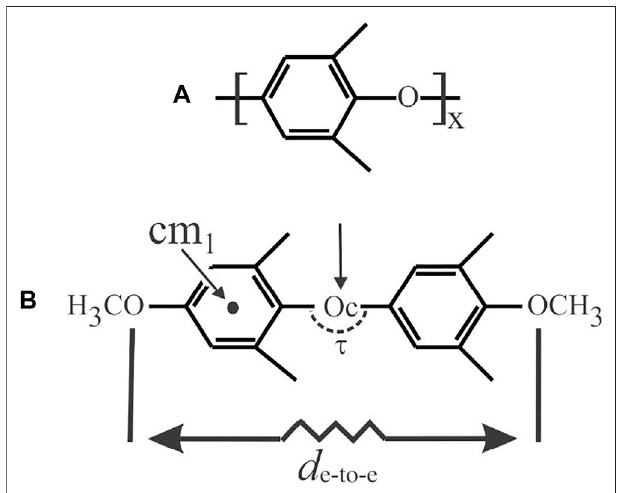
FIGURE 3 | PPO polymer (A) and methyl-terminated model dimer (B) used in the calculations of potential energy. The center of mass of the phenyl ringcm 1 andthemodeldimerOcisindicatedin (B) withanarrow.Thevalence angle at the central Oc atom Cph-Oc-Cph ( τ ) and the end-to-end distance d e-to-e are indicated.